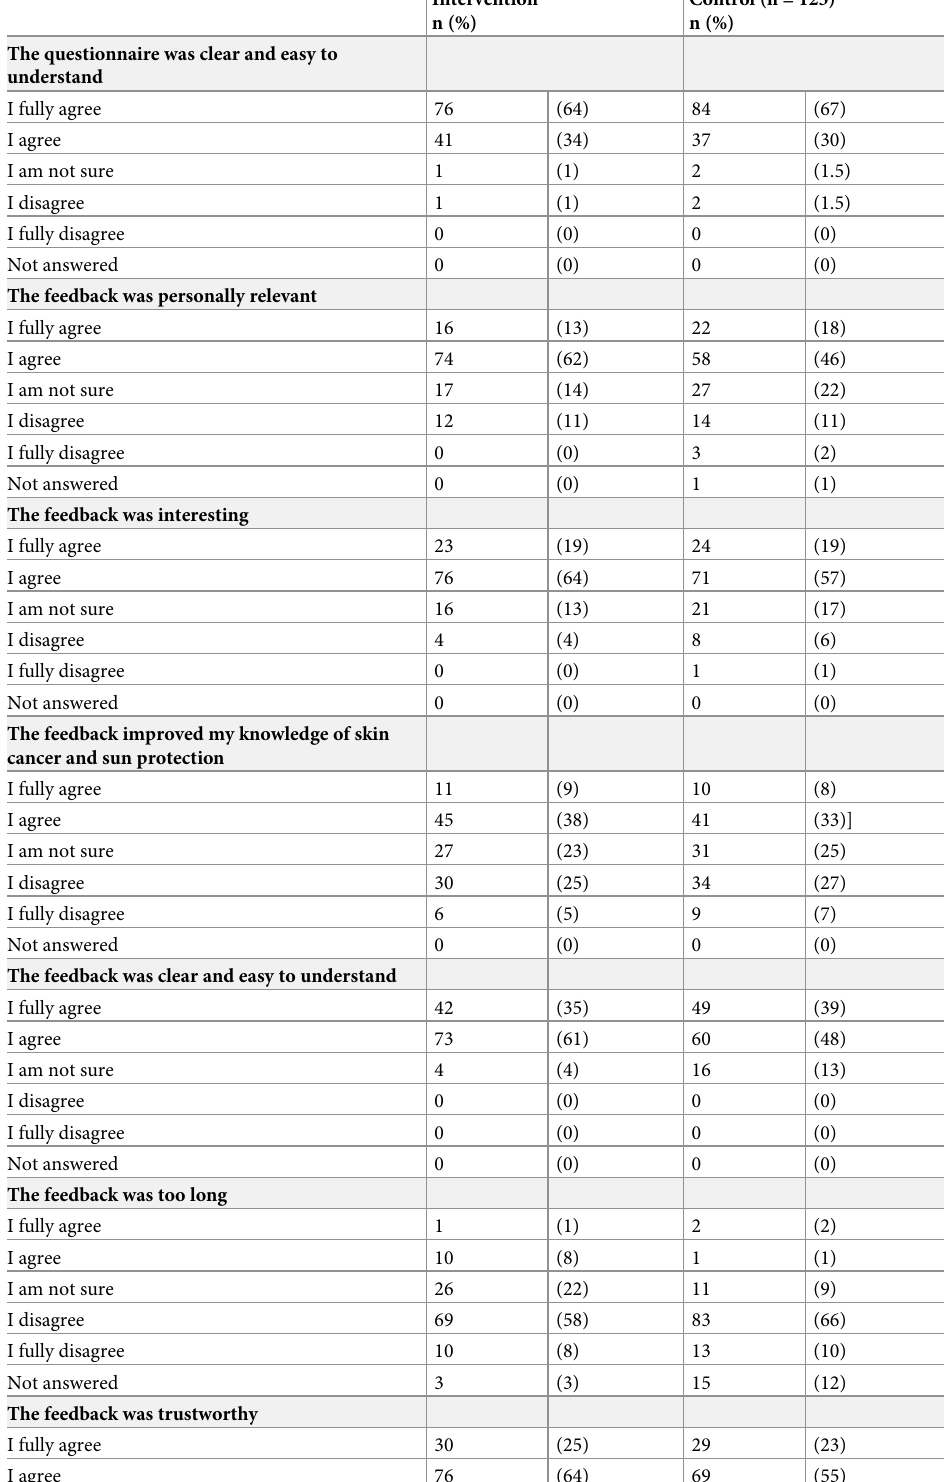
Table 3. Process outcomes in the intervention and control